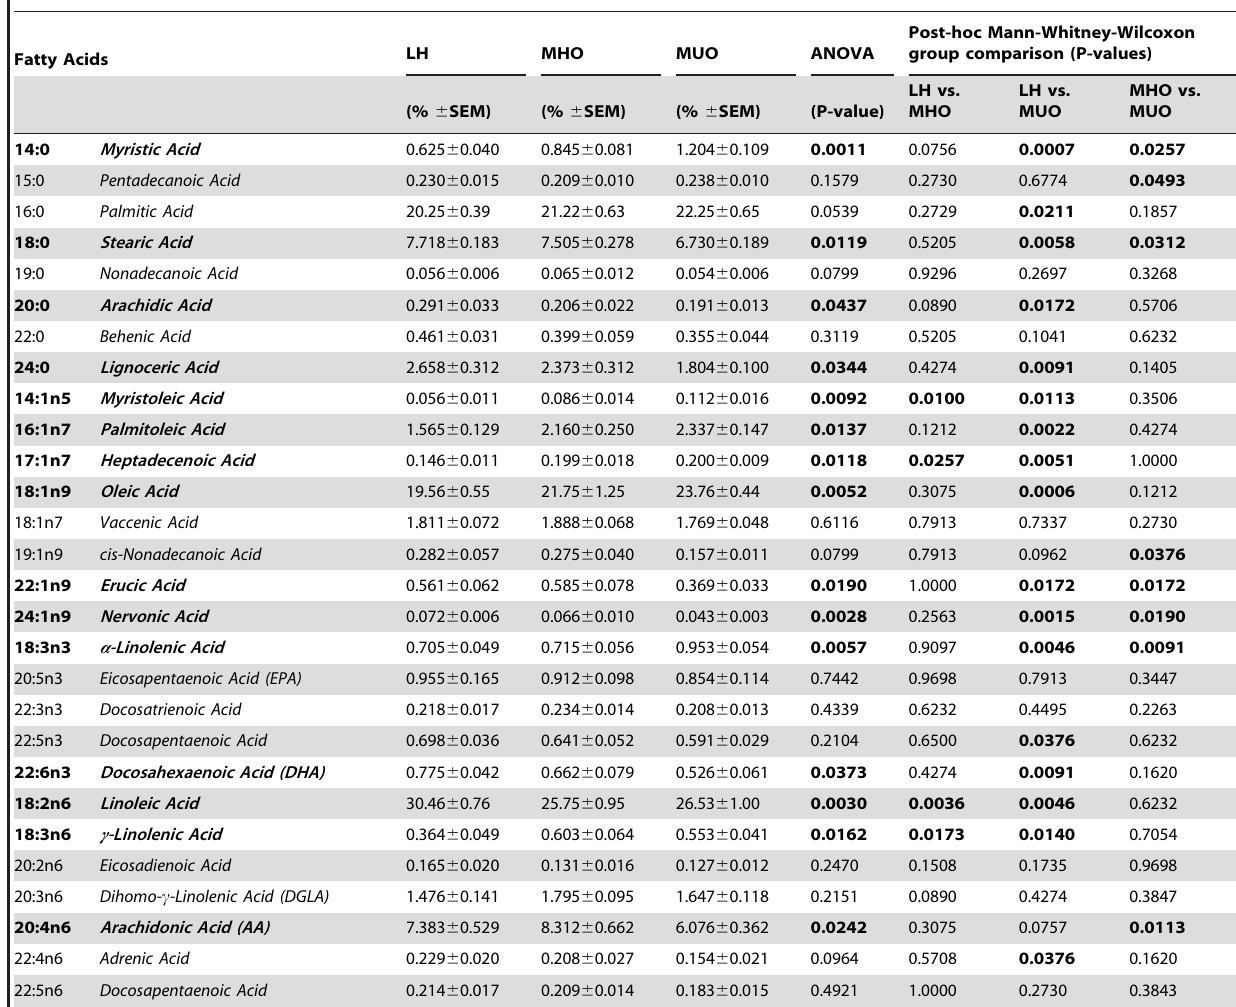
Table 3. Mean relative percentage values of total fatty acids in